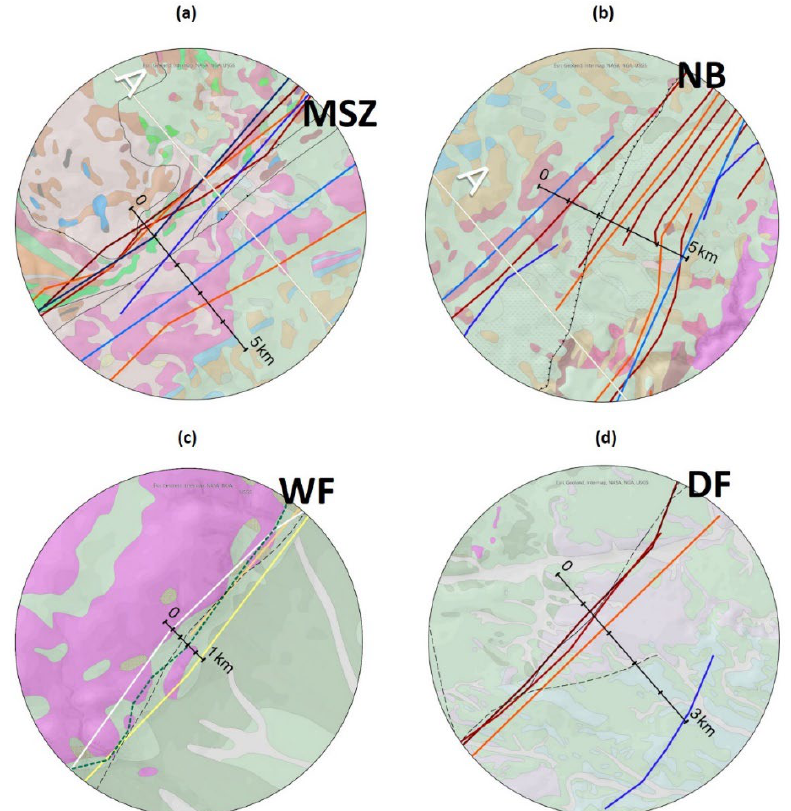
Figure 11. Detailed view of Figure 10 at the faults of concern along profile A. ( a ) Detailed view from Figure 10a of lineament position at MSZ, ( b ) at the nappe boundary NB, ( c ) at DF. ( d ) Detailed view from Figure 10b of lineament position at WF. Legends see Figure 10 a,b, respectively.